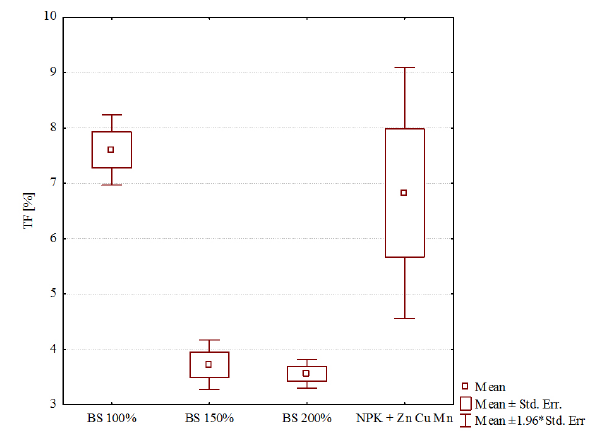
Figure 2: Transfer Factor for Zn.